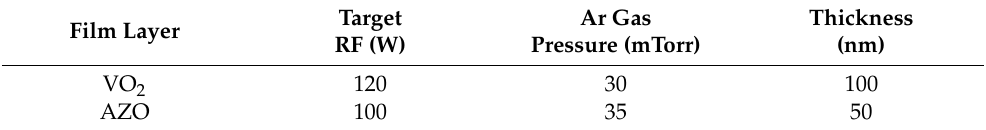
Table 1. Growth parameters for different layers of VO 2 and AZO/VO 2 thin film samples. Film